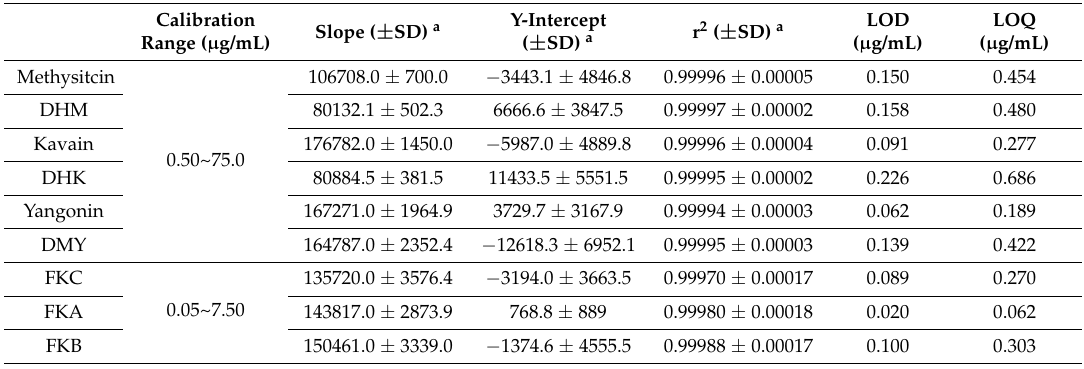
Table 3. Calibration parameters for kavalactones and flavokavains from three different calibration